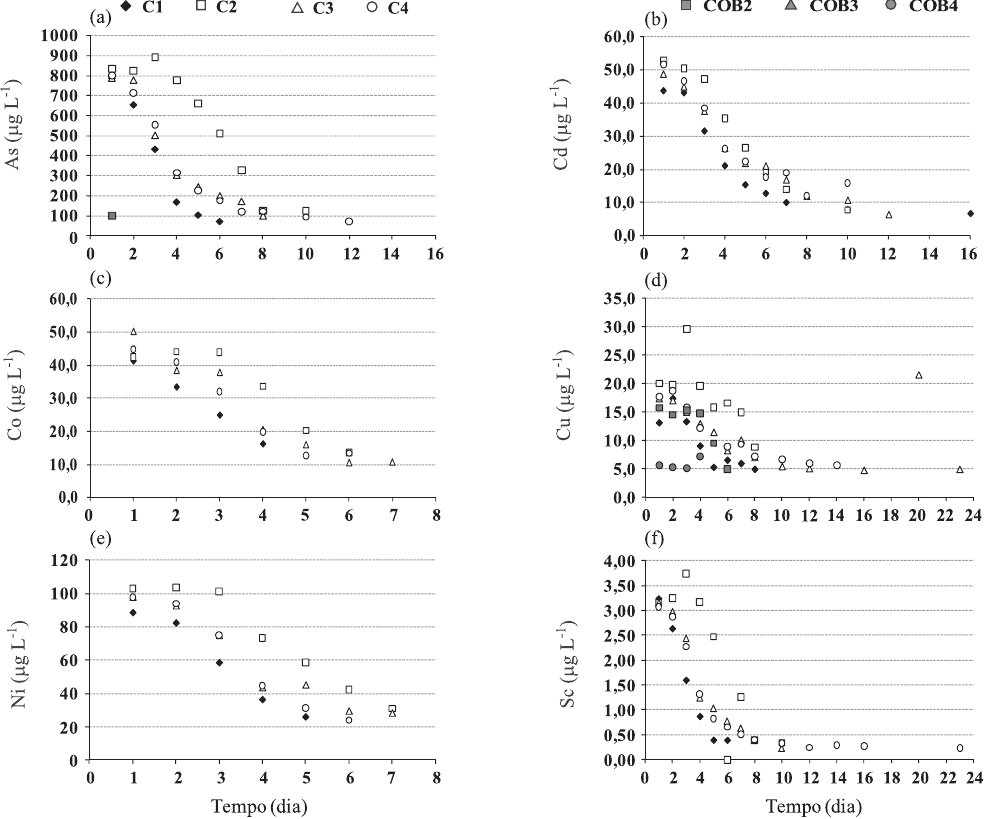
Figura 6. variações de elementos-traço (As, Cd, Co, Cu, ni e sc) nas águas lixiviadas ao longo do